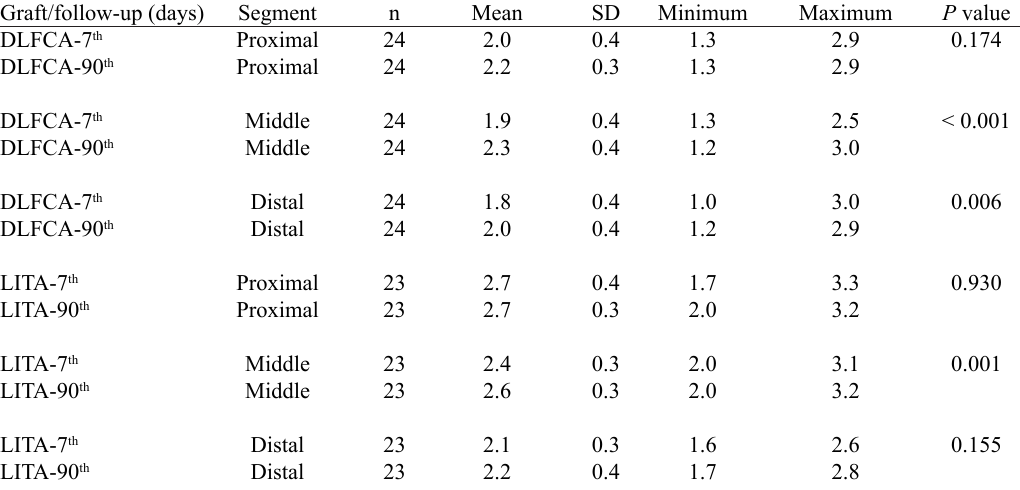
Table 1. Comparison of inner diameters (mm) of the LITA and DLFCA, 7 and 90 days after CABG Graft/follow-up